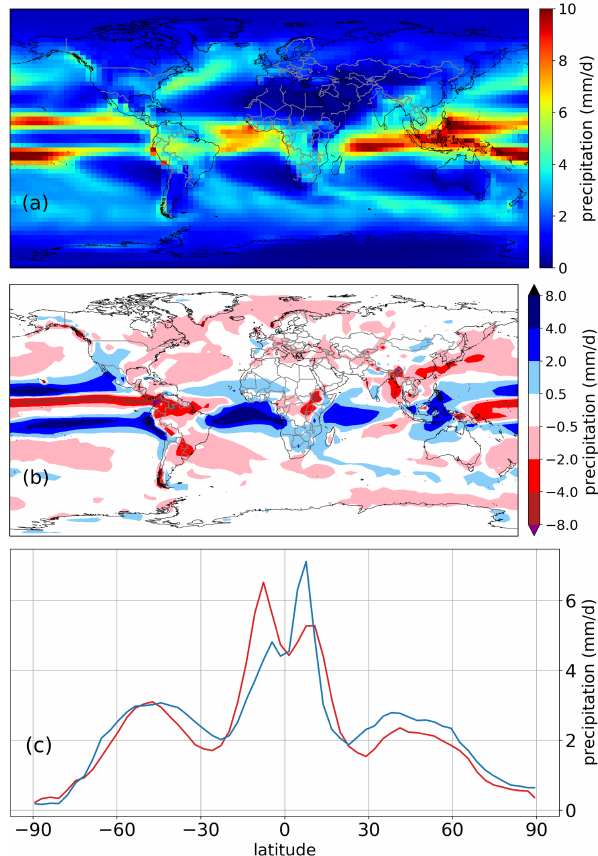
Figure 7. (a) Global mean precipitation of the TR experiment for the 1994–2003 period. (b) Precipitation anomalies between CM2Mc-LPJmL (TR) and ERA5 data over the 1994–2003 period. (c) Latitudinal temperature mean of TR (red line) and ERA5 data (blue line) over the 1994–2003